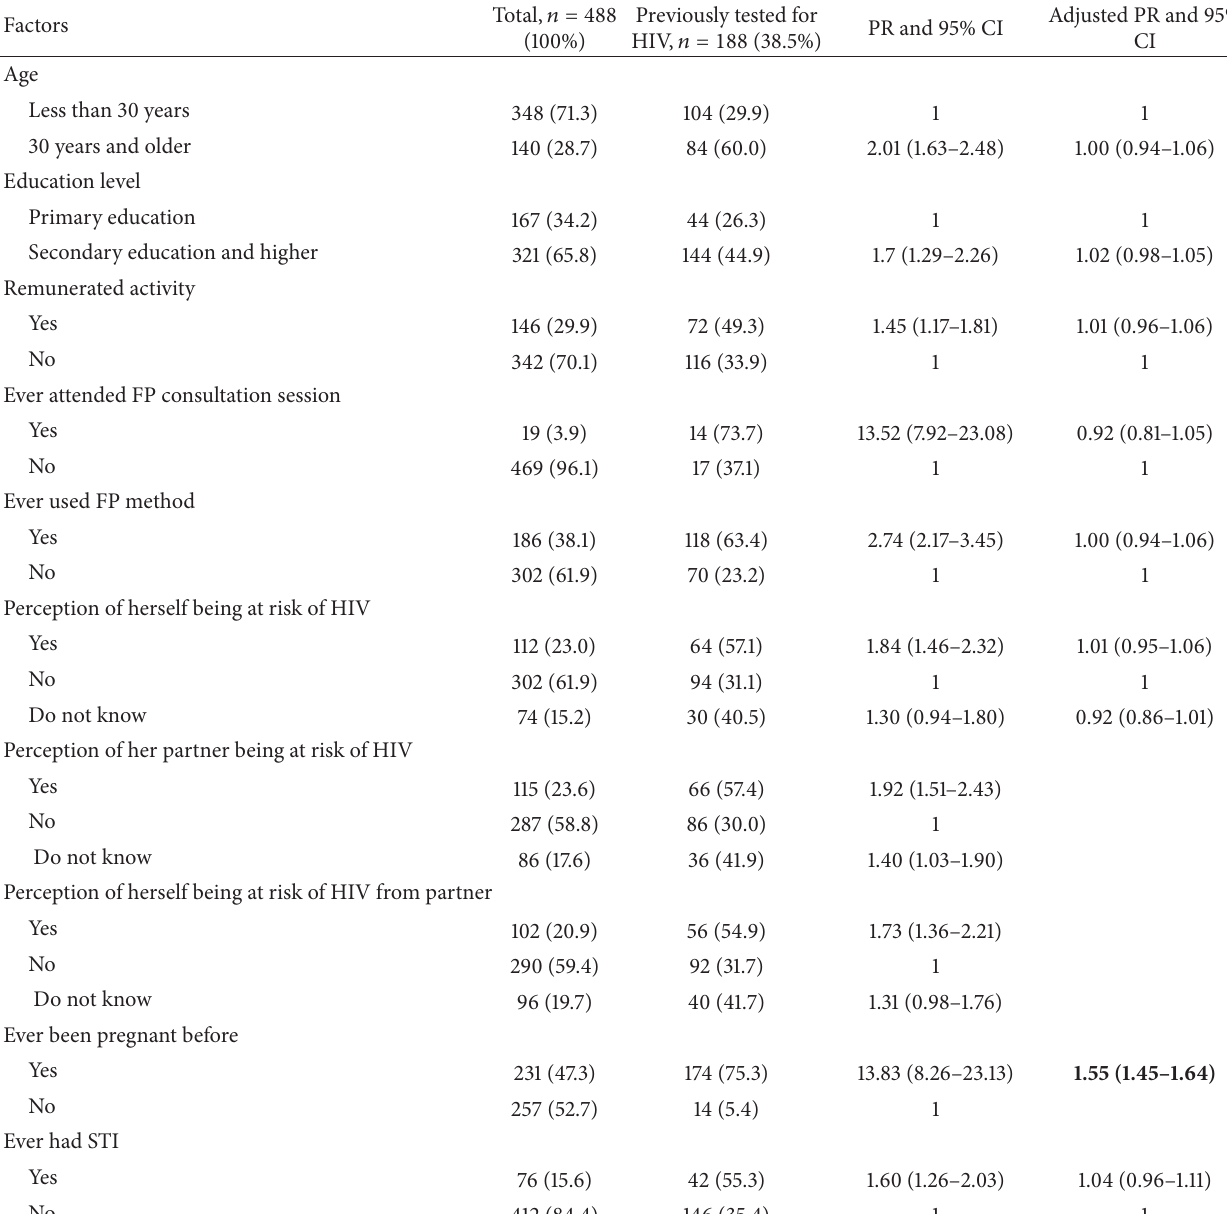
Table 2: Factors associated with previous HIV testing among pregnant women, Tbilisi, Georgia, 2009-2010, ANRS 12127 Prenahtest.